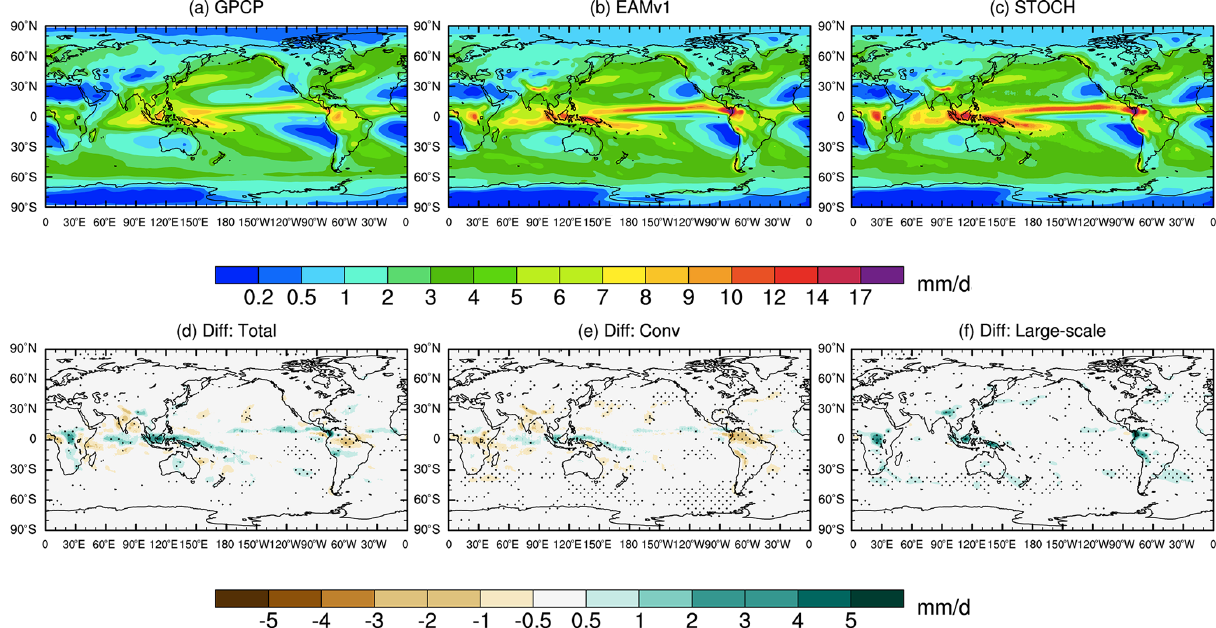
Figure 11. Global distributions of total precipitation for (a) GPCP, (b) EAMv1 and (c) STOCH, as well as the differences of (d) total, (e) convective and (f) large-scale precipitation between STOCH and EAMv1. Differences with a confidence level greater than 95% in (d–f) are stippled.